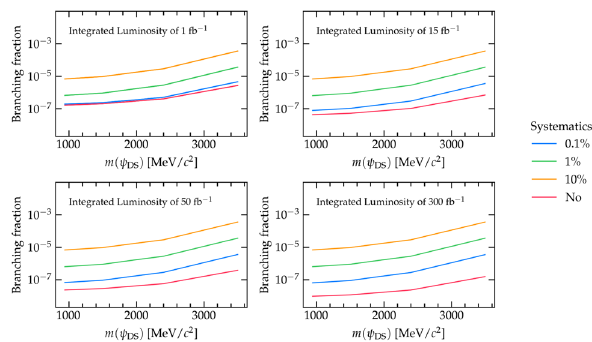
Fig. 6 Projectedsensitivityintermsofbranchingfractionsexcludedat 95% CL for the B 0 → ψ DS Λ( 1520 ) channel. The sensitivity is shown assumingintegratedluminositiesof1,15,50and300fb − 1 .Ineachcase, different assumptions are made regarding the systematic uncertainty of the background yield, ranging from no uncertainty at all to 10%